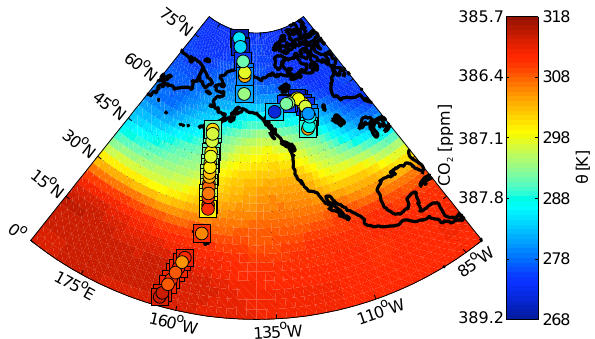
Fig. 3. HIPPO partial CO 2 columns overlaid on January monthly mean potential temperature, θ . The inner circle is colored by h CO 2 i , while the outer square is colored by θ at 700hPa at the time the profile was